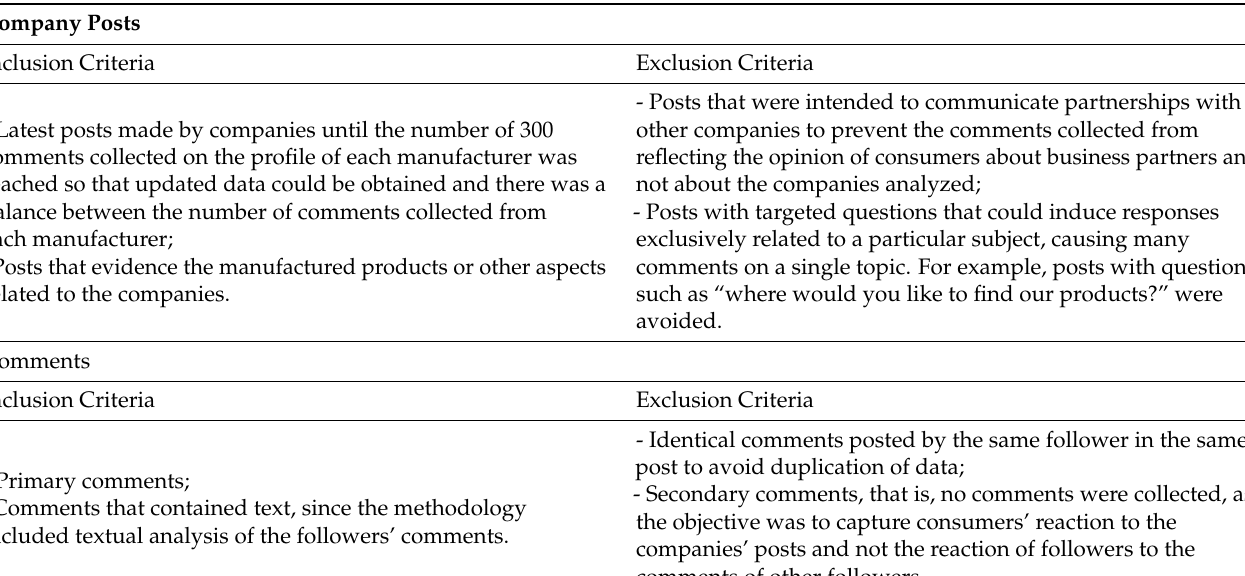
Figure 1. Research stages. Instagram—Incrível Seara and Fazenda Futuro. Table 1. Inclusion and exclusion criteria for posts and